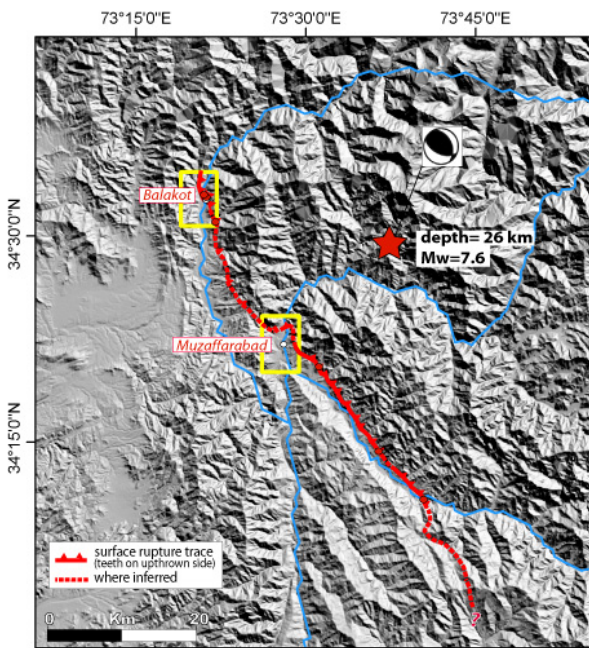
Fig. 1. The Balakot-Bagh surface fault rupture (red line from Kaneda et al., 2008). Yellow rectangles include the Muzaffarabad and Balakot areas of the analysed VHR images. USGS Location (http://neic.usgs.gov) and Harvard CMT solution of the earthquake (www.seismology.harvard.edu/CMTsearch) are shown.